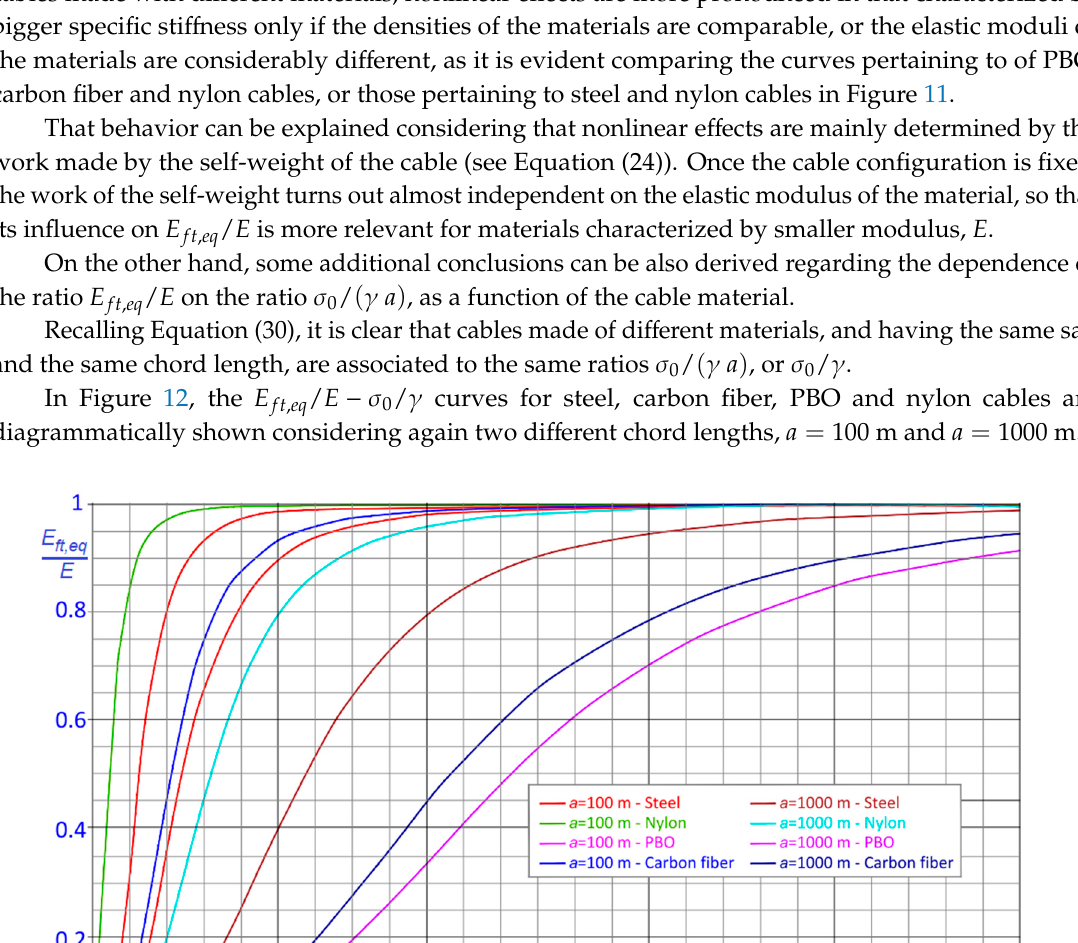
(cid:3006) (cid:3295),(cid:3280)(cid:3292) − σ 0 curves for steel, carbon fiber, PBO and nylon cables: 𝑎 = 100 m ; 𝑎 = 1000 m. Figure 12. E t , eq − (cid:3097) (cid:3116) γ curves for steel, carbon fiber, PBO and nylon cables: a = 100 m; a E (cid:3006) (cid:3082)